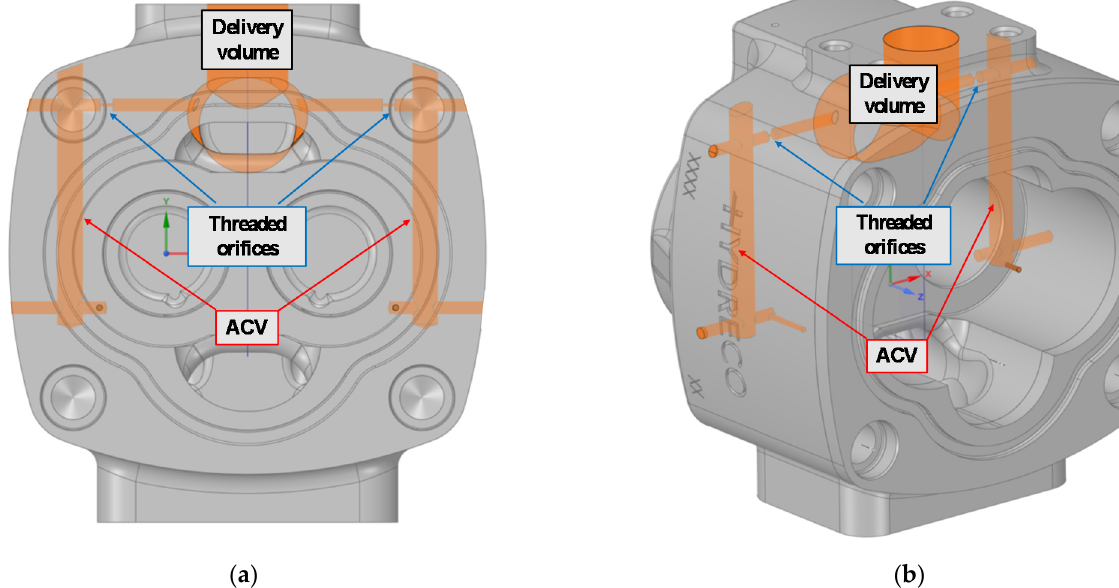
Figure 13. Pump housing views with highlighted ACV surfaces: ( a ) Front view; ( b ) Prospective view.